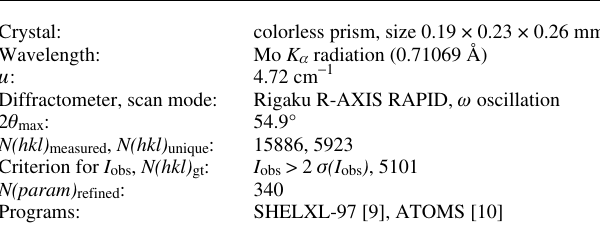
Table 1. Data collection and